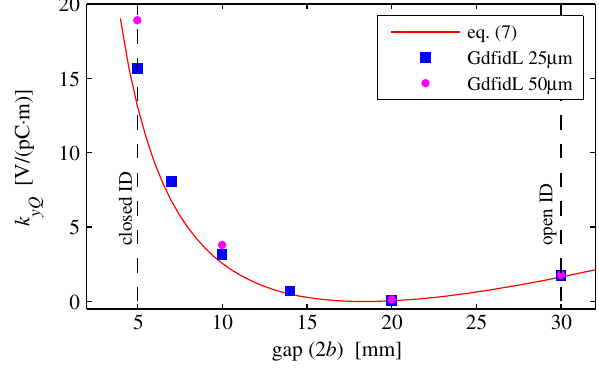
FIG. 5. Quadrupole kick factor — gap dependence.